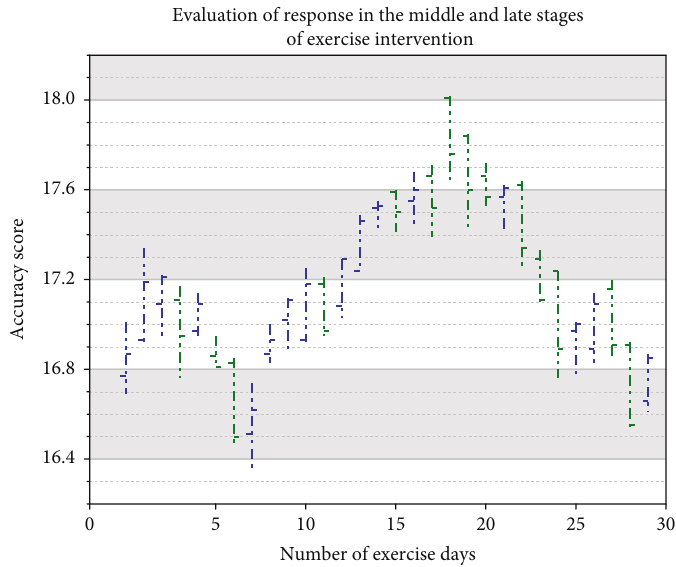
Figure 2: Evaluation of response in the middle and late stages of exercise